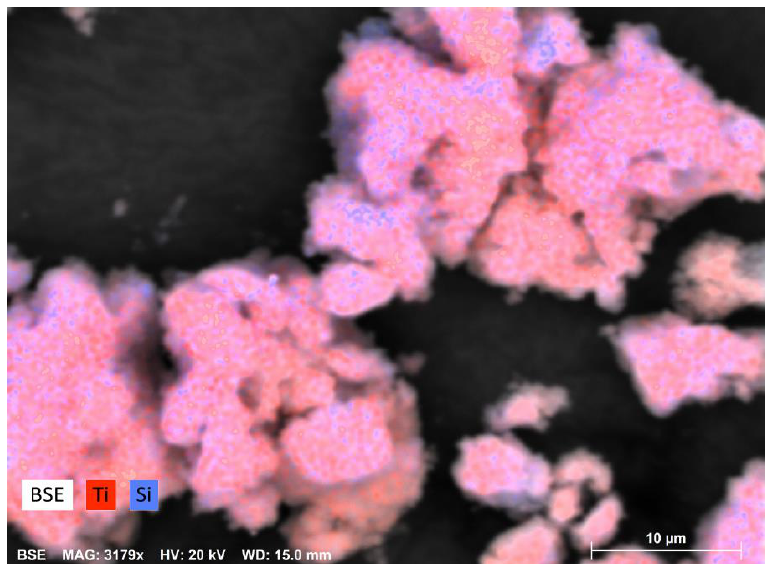
Figure 8. SEM backscatter image with XPS elemental mapping. Silica fume grains are shown in blue hues, while titanium is shown in red.